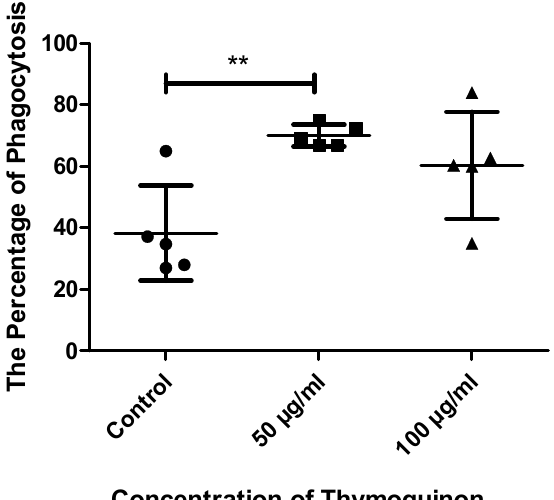
Figure 8. Comparison of the percentages of macrophage phagocytosis in the three groups. The phagocytosis abilities of the cells in different conditions (untreated macrophages, 50 µ g/mL TQ- treated macrophages and 100 µ g/mL TQ-treated macrophages were checked using flow cytometry to detect the percentage of macrophages that phagocyted FITC-conjugated E. coli . The results showed increased abilities of treated cells for phagocytosis, as significant results detected with the 50 µ g/mL TQ showed that 68% of the cells phagocytosed E. coli compared to 41% of control cells. In addition, 58% of the 100 µ g/mL TQ-treated cells phagocytosed E. coli . n = 5. ** p value ≤